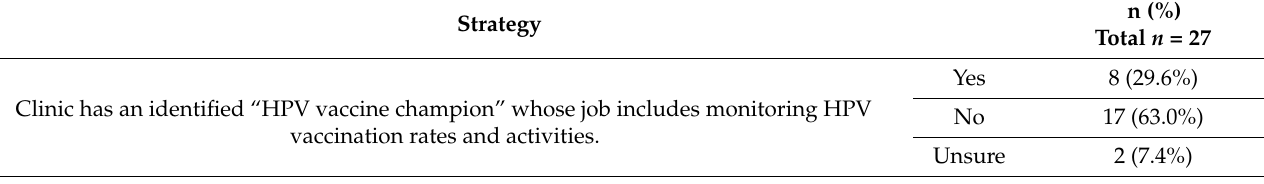
Table 2. Strategies clinics use to increase HPV vaccination rates. Strategy